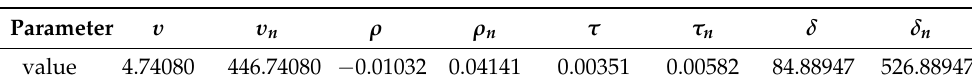
Table 2. Hyperparameter values.